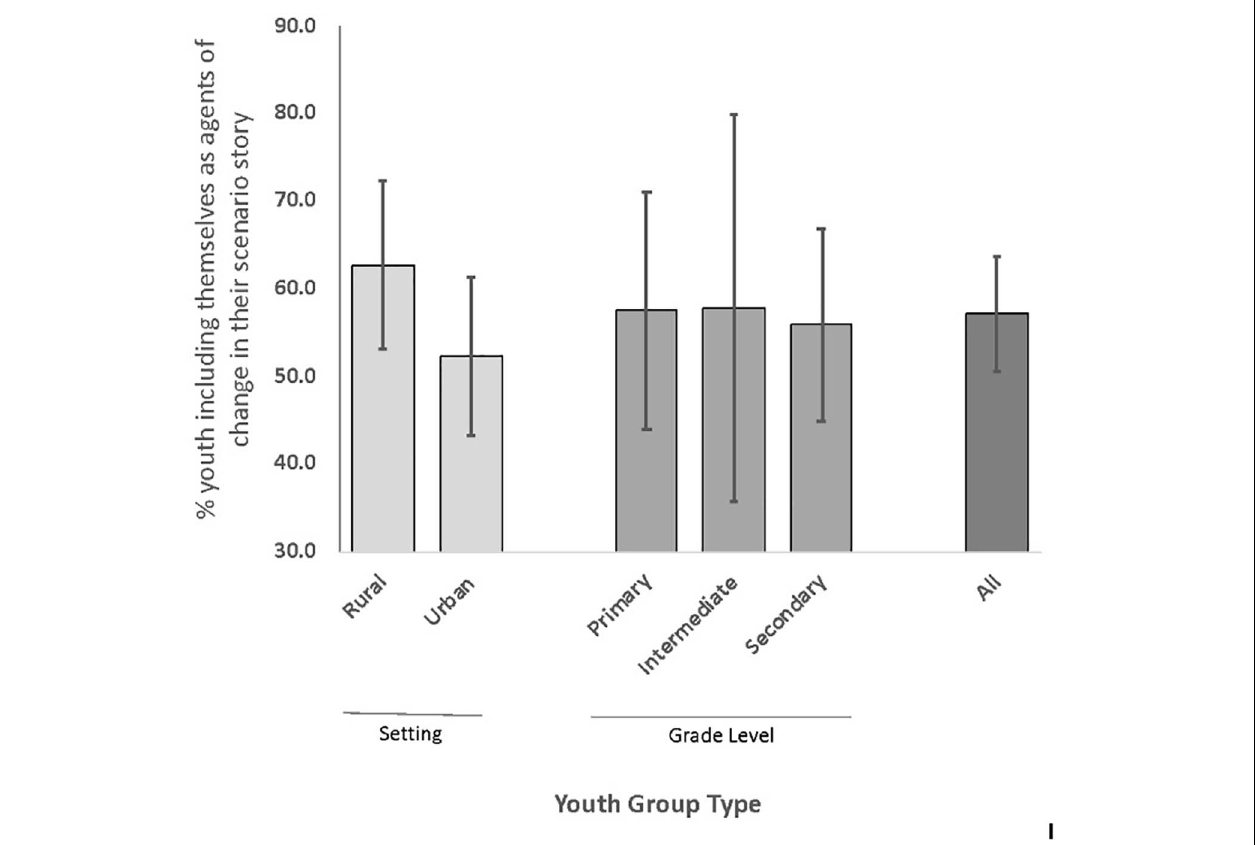
FIGURE 3 | Percentage of youth work samples ( n = 126) illustrating youth themselves as agents of berry stewardship action from rural and urban Alaska learning settings and from different grade levels (primary = grades K-3, intermediate = gr. 4–6, secondary = gr. 7–12).